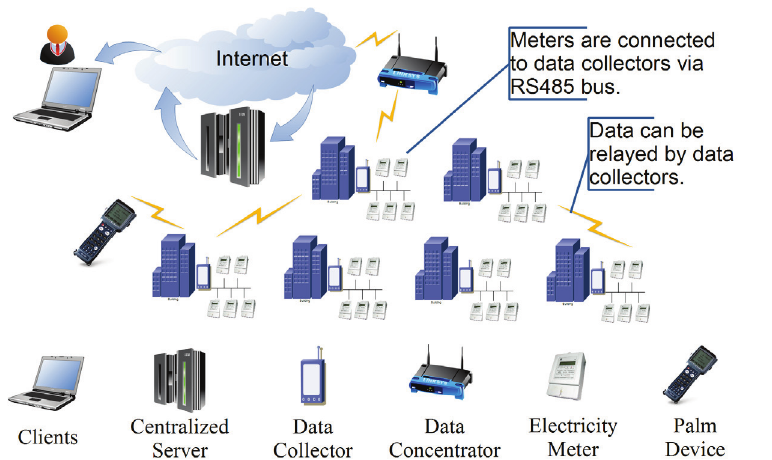
Figure 1. Architecture of